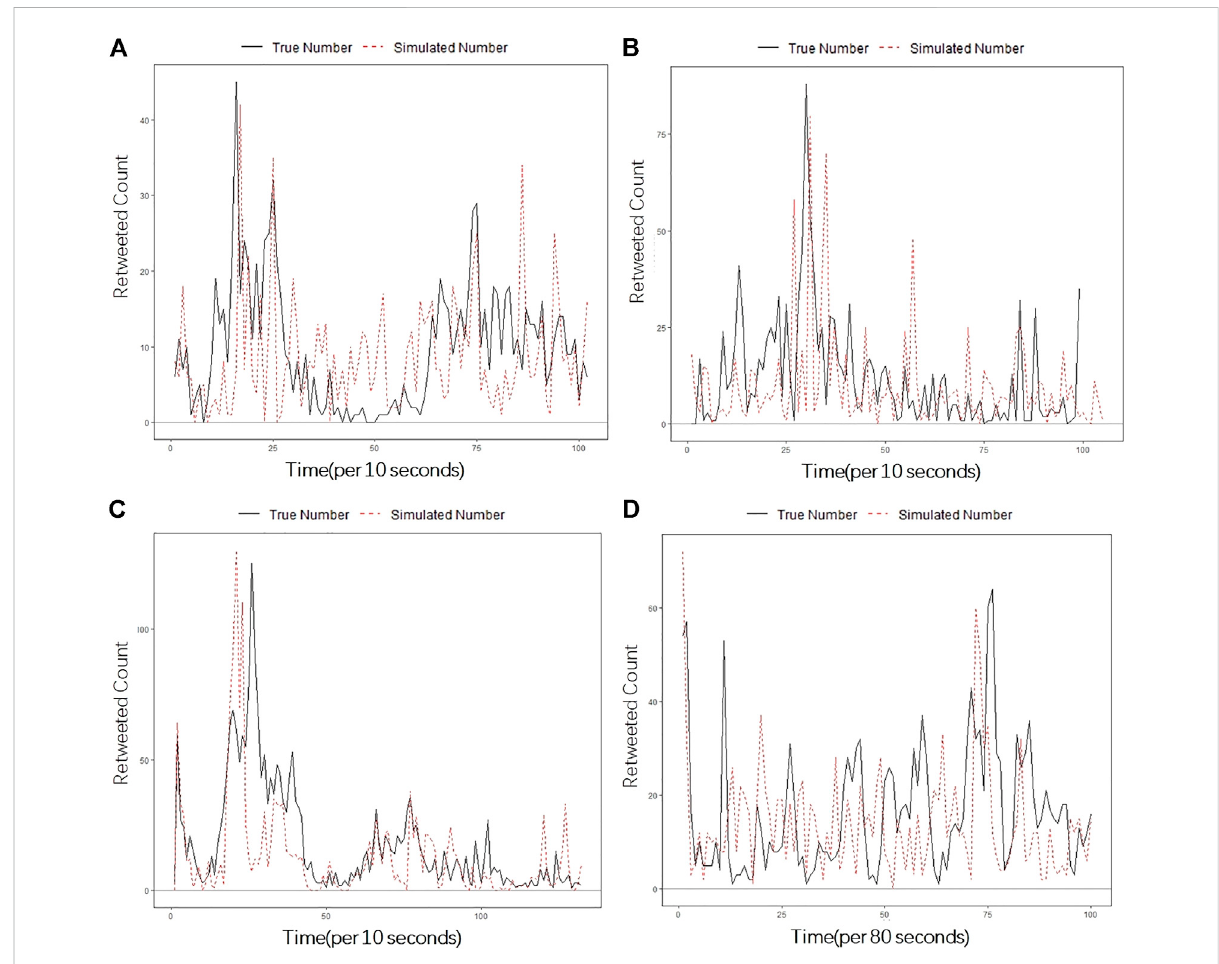
FIGURE 5 Fitting results for the four representative tweets by the improved Hawkes model. Panel (A) , (B) , (C) , and (D) corresponds to the fi tting results of tweet (a), (b), (c), (d) respectively.